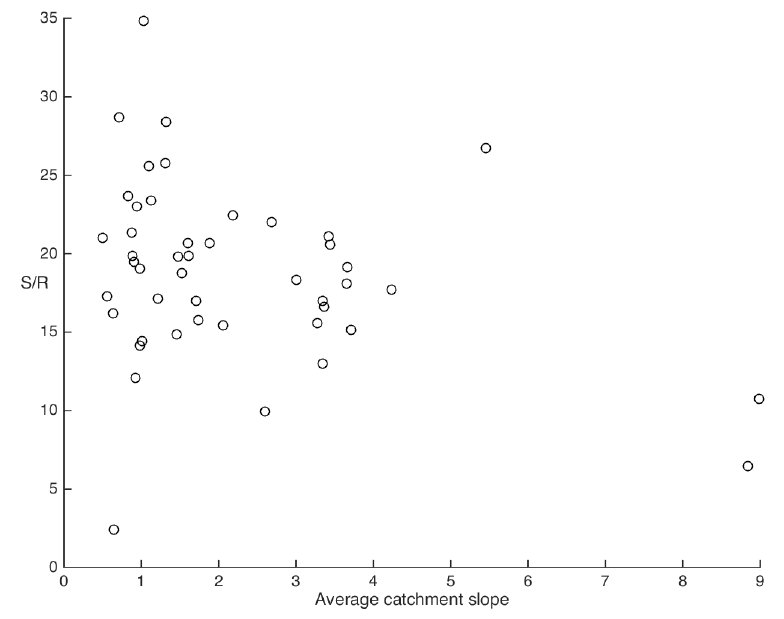
Figure 9. Ratio of Sen’s slope estimator ( S ) and the resultant length ( R ) in mm yr − 1 as a function of average catchment slope in degrees for the American catchments with a significant trend in discharge and significant LUC and/or CC values.